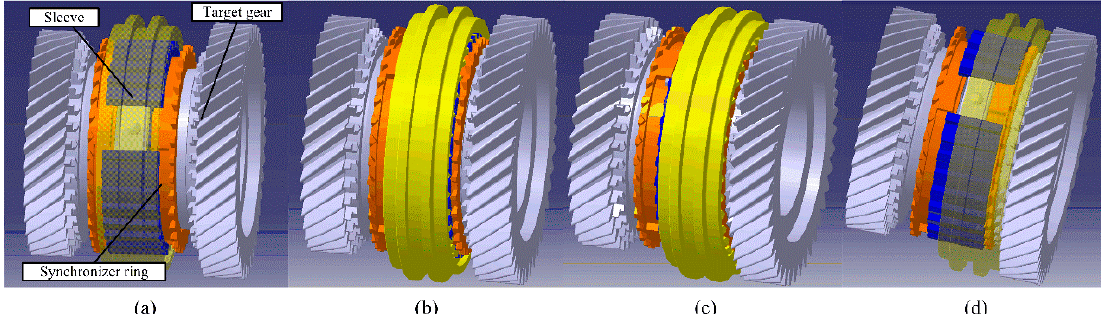
Figure 7. Four phases of the gearshift synchronization process: ( a ) the first phase, eliminate the gap; ( b ) the second phase, synchronization process; ( c ) the third phase, turn and cross the teeth of the synchronizer ring; and ( d ) the fourth phase, cross the teeth of the target gear and mesh with the target gear.